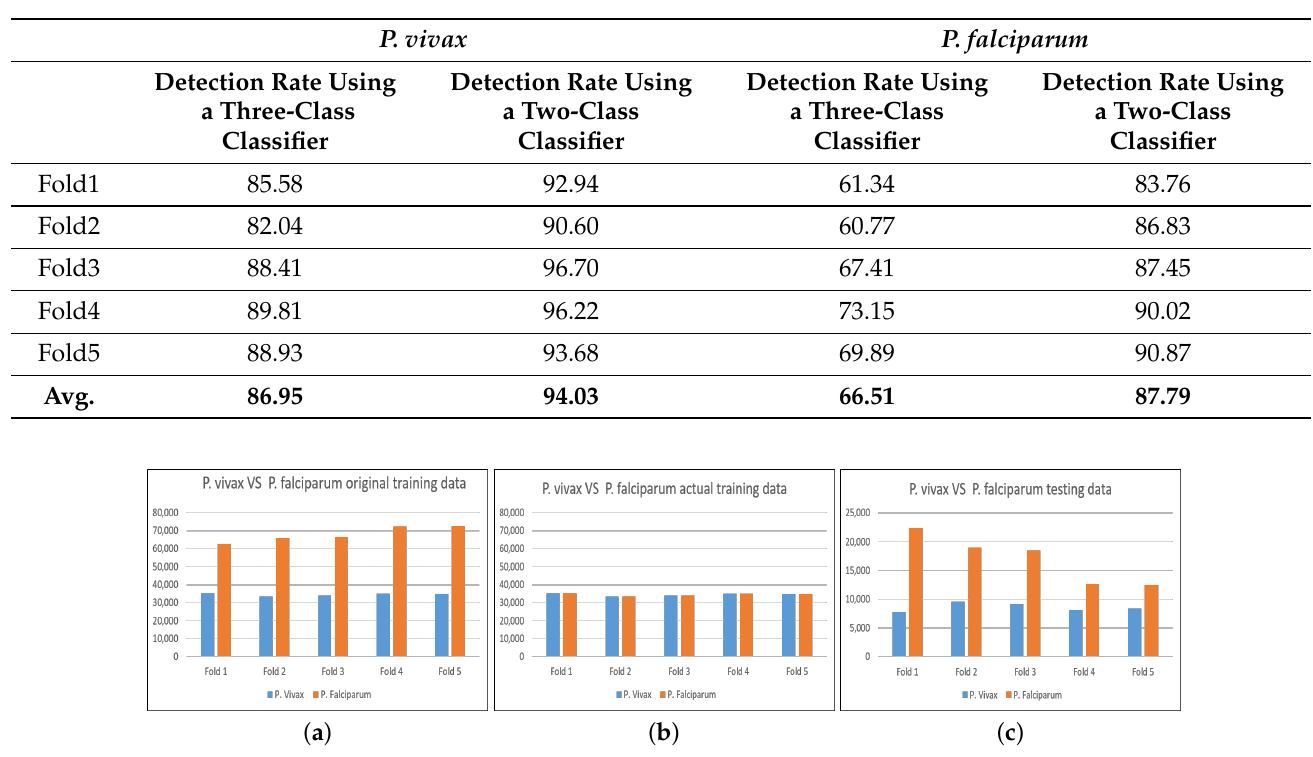
Table 3. Performance evaluation of Mask R-CNN for detecting P. vivax and P. falciparum parasites in thick smear microscopy images.